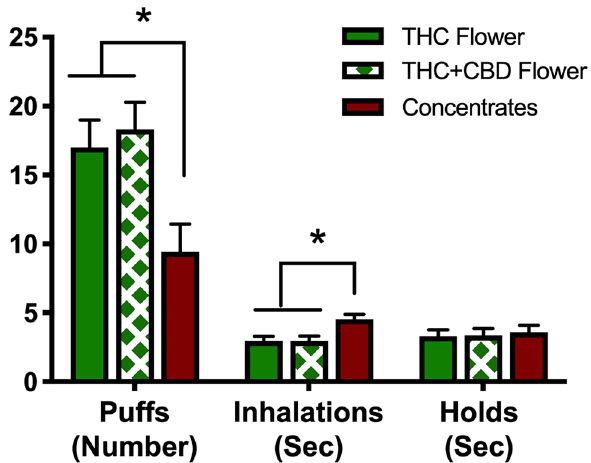
Figure 2. Cannabis consumption across groups. Bars represent mean number of puffs, mean duration of inhalations, and mean durations of holds in the THC flower, THC + CBD flower, and concentrates groups. Error bars represent standard errors of the mean. The three groups showed significant differences in number of puffs across the three cannabis-using groups, F (2,57) = 5.79, p = .005, η 2 p = .17. Follow up post hoc comparisons indicated that the concentrates group took significantly fewer puffs than the THC flower ( p = .009) and THC + CBD flower ( p = .003) groups. The difference between the two flower groups was not significant ( p =